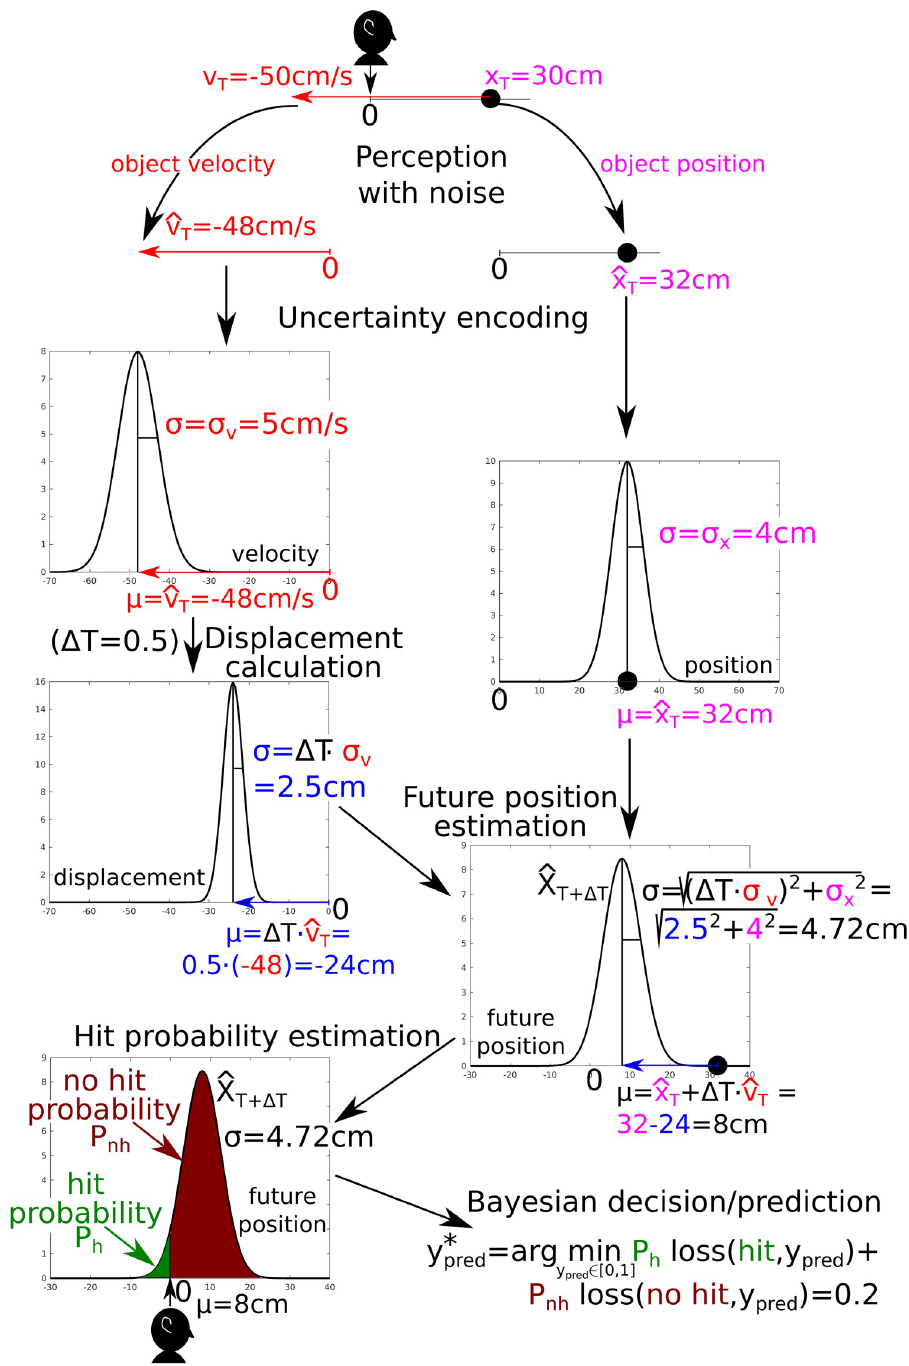
Fig 1. Schema and illustrative example of the contact prediction model. Say an object (black circle) is x = 30cm T from the body (black head) and is approaching with velocity v T = − 50 cm / s . Perception with noise . The nervous system estimates the position and velocity of the object with respect to our body with a given uncertainty. For instance, we may estimate ^ x ¼ 32 cm and ^ v ¼ (cid:0) 48 cm = s . Assuming that the noise is Gaussian, the values ^ x ; ^ v are samples from T T T T normal distributions N ( μ = x T , σ x ), N ( μ = v T , σ v ), where σ x (here, for illustration σ x = 4 cm ), σ v (here σ v = 5 cm / s ) reflect the level of noise. Further, we assume the brain encodes not only point estimates ( ^ x ; ^ v ), but also their uncertainty— T T the estimates are encoded as normal distributions N ð m ¼ ^ x ; s ¼ s Þ and N ð m ¼ ^ v ; s ¼ s Þ , respectively (see T x T v Derivation of the normative impact prediction model for details). Displacement calculation . According to Δ T , the object displacement distribution is N ð m ¼ D T � ^ v ; s ¼ D T � s Þ . Future position estimation . Knowing the T v